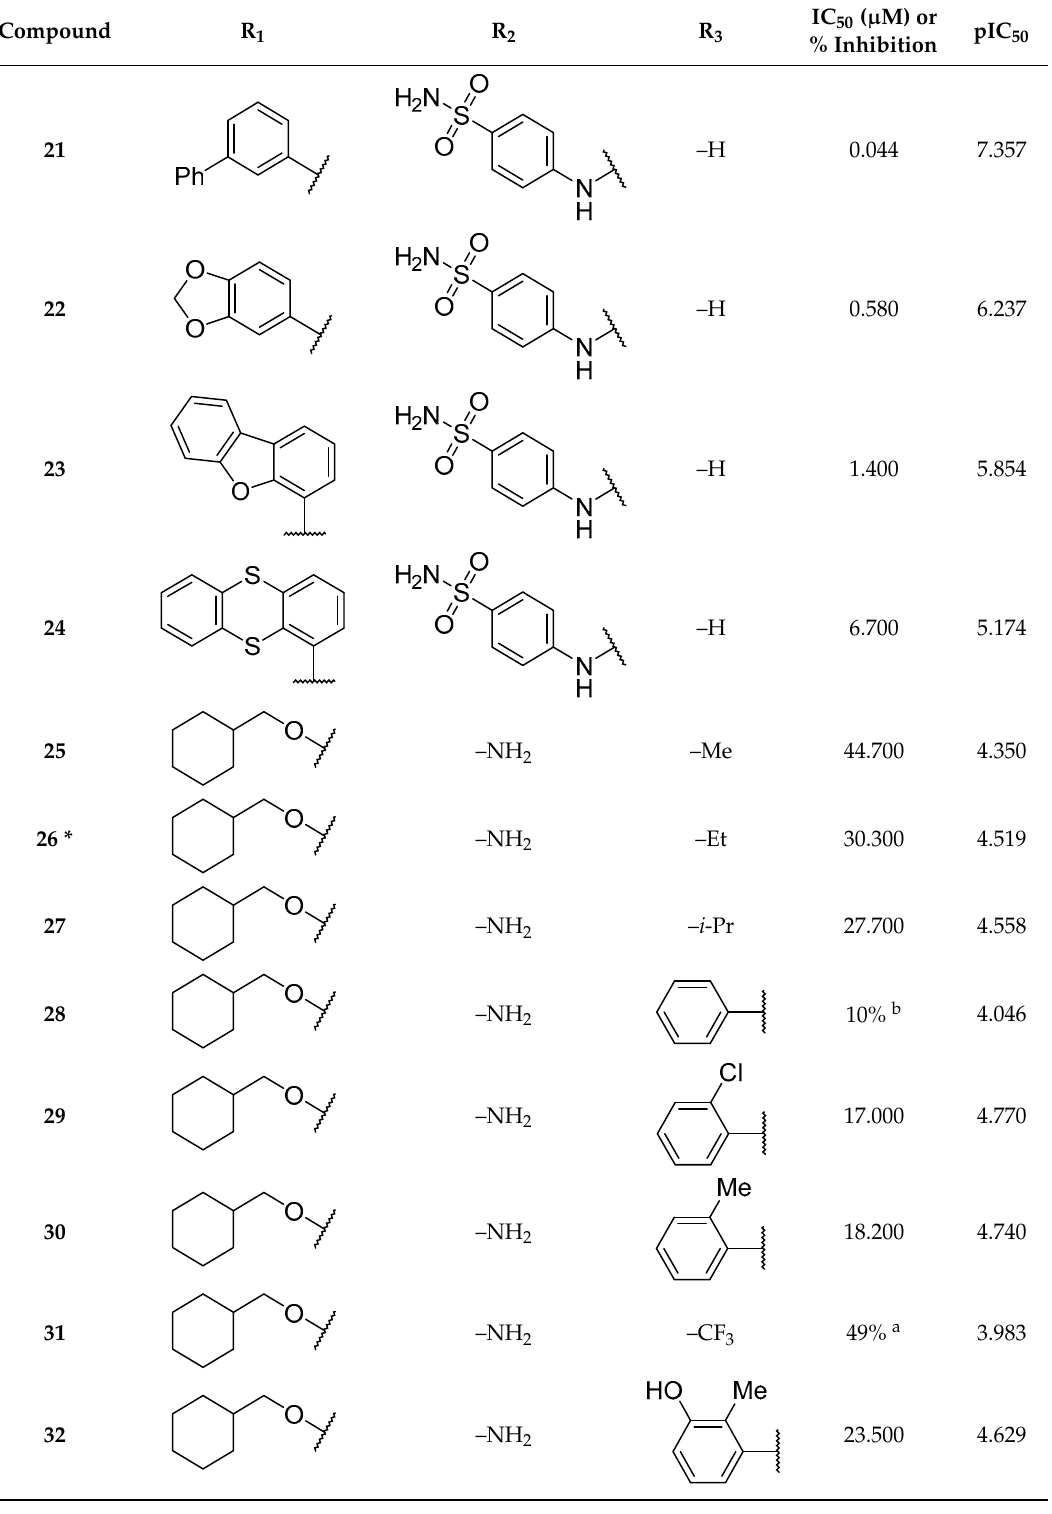
Table 4. The structures and the pIC 50 values of the dataset